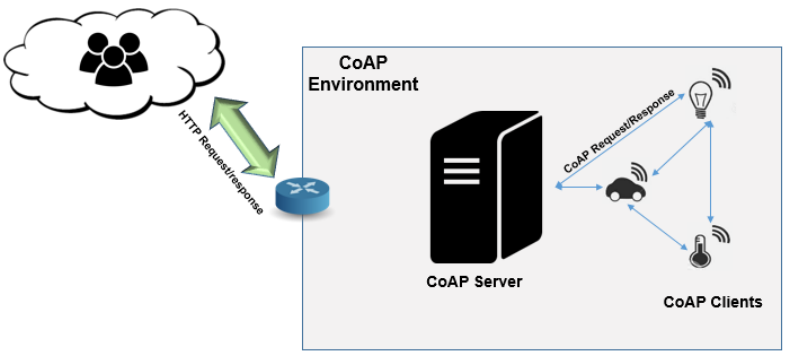
Figure 16. Illustration of the CoAP architecture.